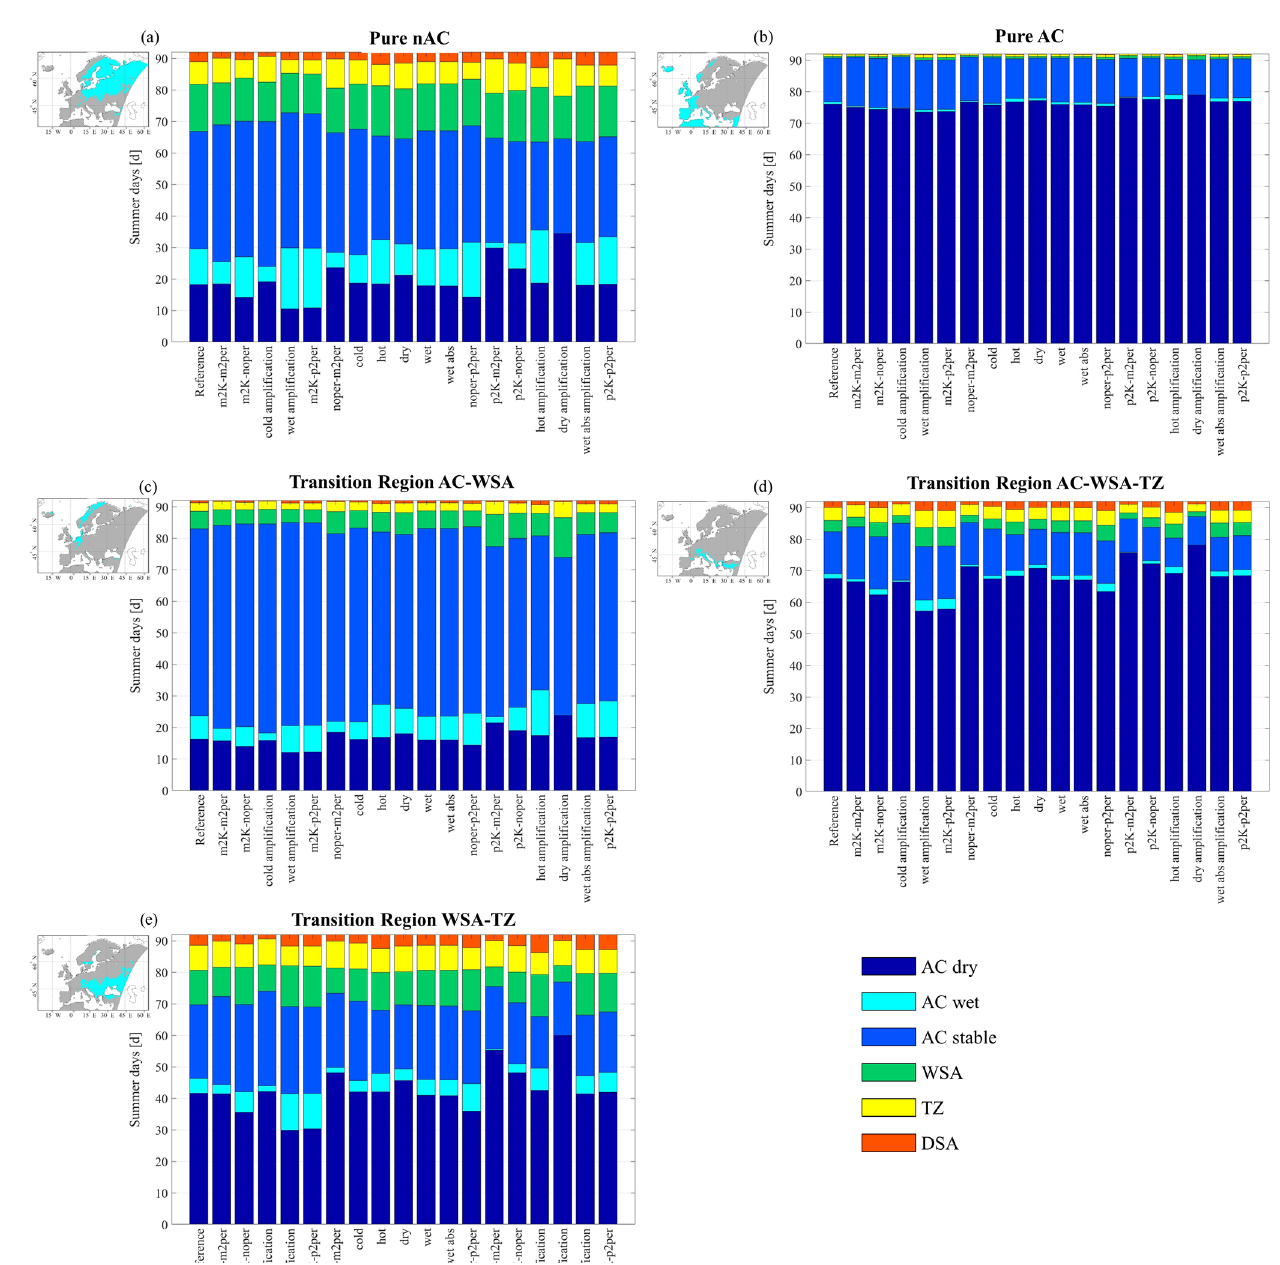
Figure 14. Average distribution of the classes in the daily classification for all modification cases spatially aggregated in (a) cells always in nAC, (b) cells always in AC, (c) cells in which the long-term classification frequently switched between AC and nAC, (d) cells in which the long-term classification frequently switched between wet soil advantage (WSA) and transition zone